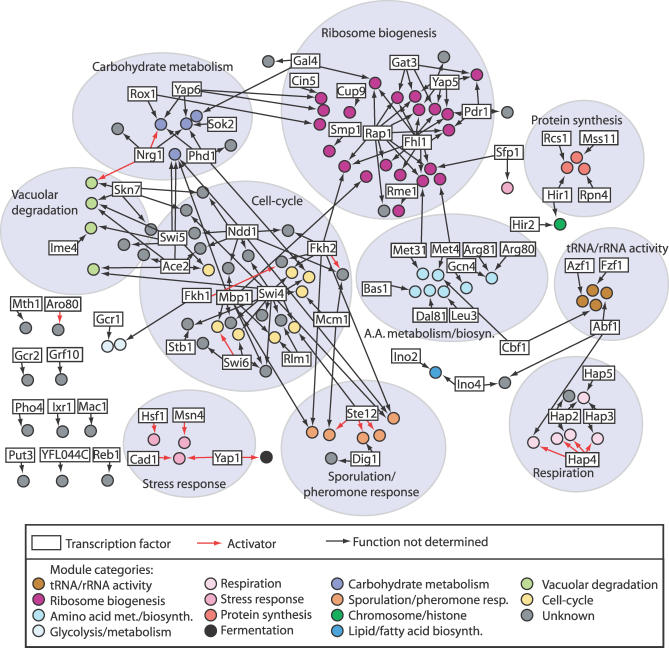
Yeast Transcriptional Regulatory ModulesNodes represent modules, and boxes around the modules represent module groups. Directed edges represent regulatory relationship. The functional categories of the modules are color-coded. (Reproduced from [15].)